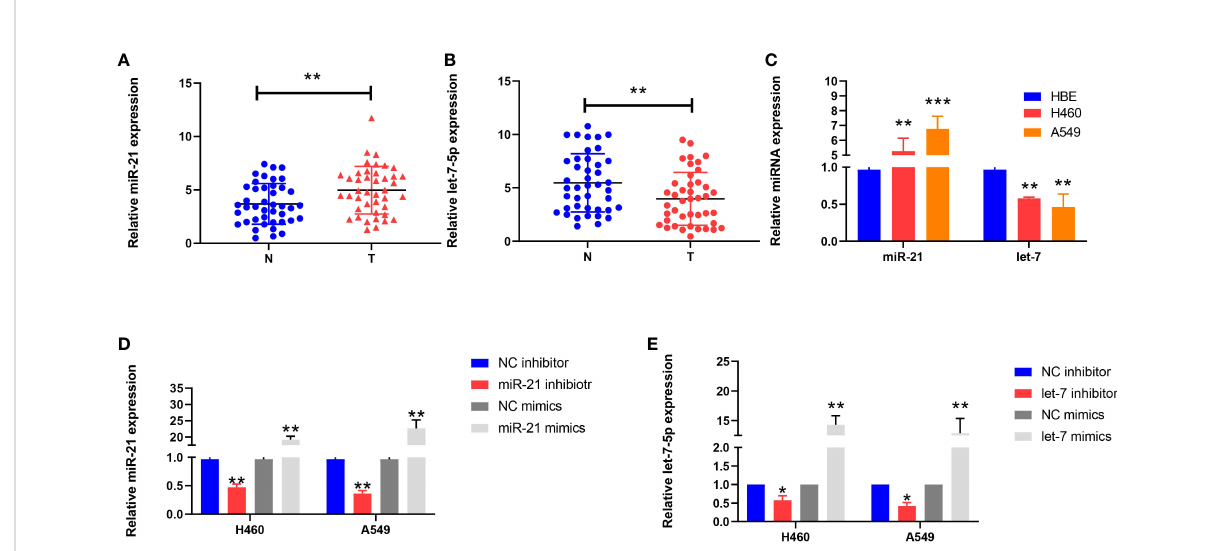
FIGURE 1 Expression of miR-21 and let-7 in lung cancer cells. (A, B) Relative expression of miR-21 and let-7 in lung cancer and paracancerous tissues. (C) Relative expression of miR-21 and let-7 in lung cancer cell lines (H460 and A549) and the normal cell line HBE. (D, E) Relative expression of miR-21 and let-7 after transfection of miR-21/let-7 inhibitors or mimics (all qRT-PCR data are represented as the means ± SDs of three independent experiments; * p < 0.05; ** p < 0.01; *** p <